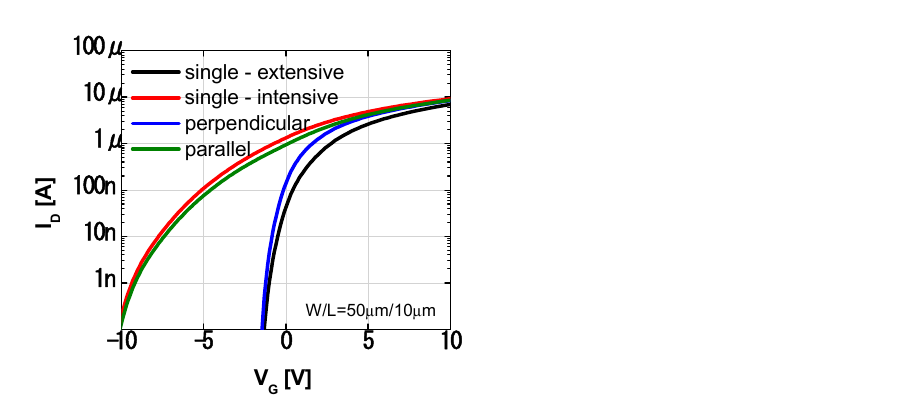
Figure 8. Simulated transfer characteristics of the multi–region structure, and two single–region structures with trap states in the extensive or intensive region.